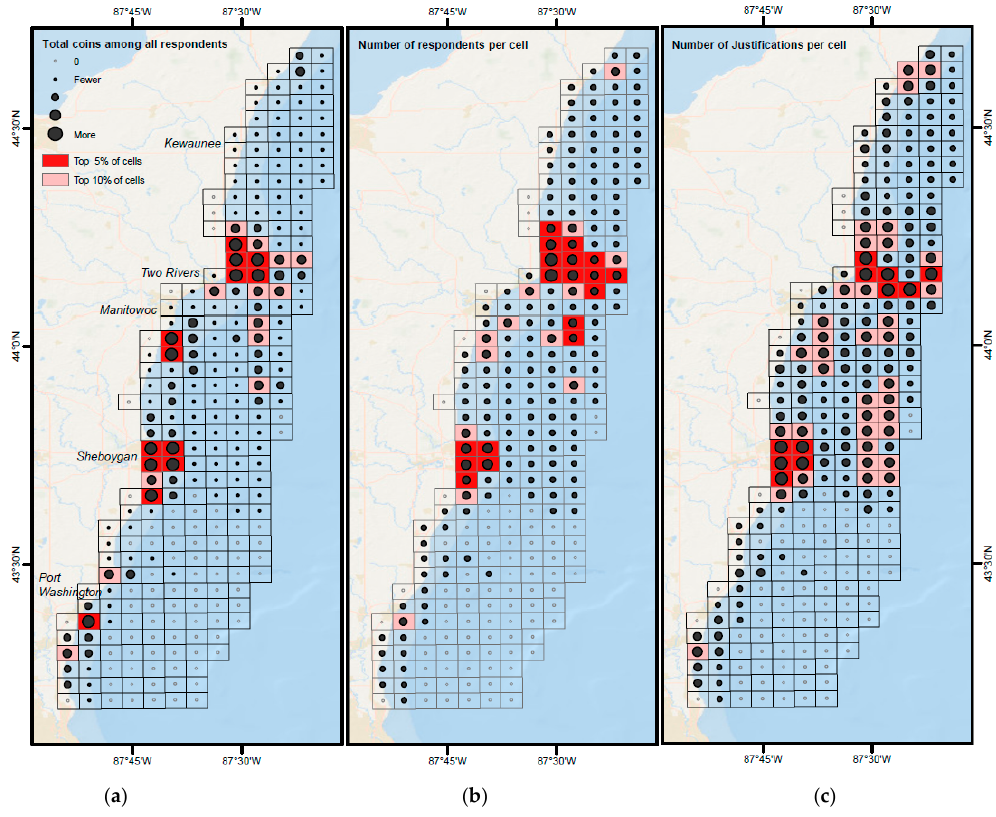
Figure 5. ( a ) Sum of all coins among all respondents in each cell; ( b ) total number of respondents allocating at least one coin in the cell; ( c ) total number of different Justifications used in each cell. The cells with the highest combined ranks based on total number of coins, number of respondents, and diversity of Justifications are plotted in Figure 6. Highest values were concentrated in small groups of cells off Sheboygan and eastward from Two Rivers. Moderately high values were more diffuse, with a loose grouping of cells south of Manitowoc and Two Rivers and a couple of isolated cells elsewhere.